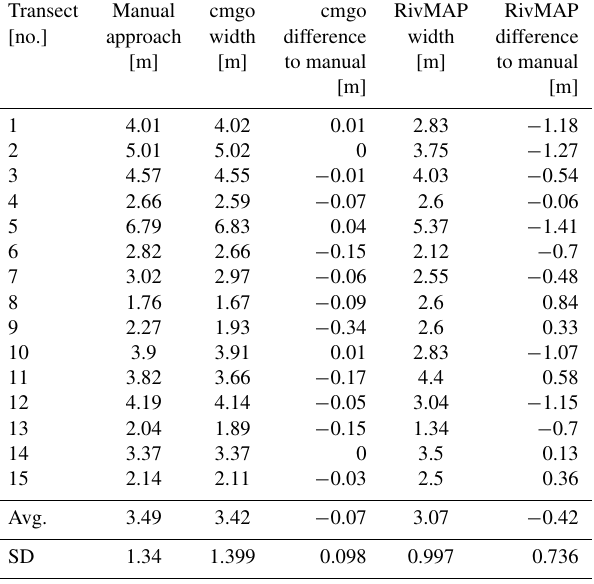
Table 3. Channel width at 15 randomly selected locations along a natural channel. The width was identified manually in a GIS, by cmgo, and by RivMAP. Differences in the width from the automated products were compared to the manual approach.